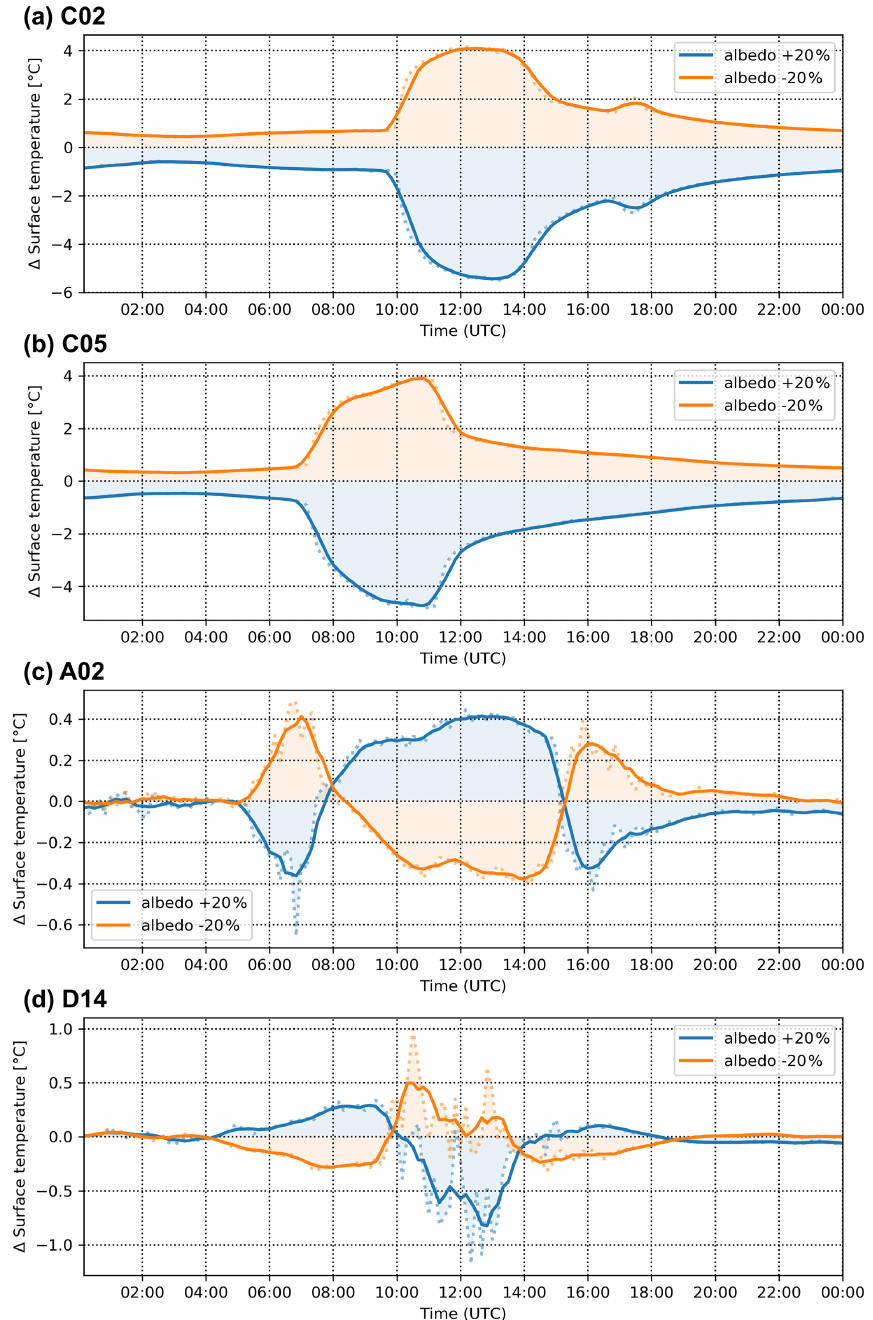
Figure 7. Differences in surface temperature in evaluation points C02 (a) , C05 (b) , A02 (c) and D14 (d) for albedo-changing scenarios SA01 (blue) and SA02 (orange). Dotted lines: 10min values; solid lines: 1h moving